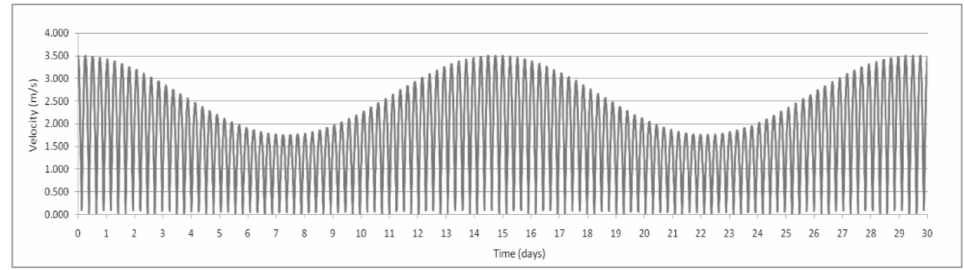
Figure 2. Thirty day tidal current velocities profile.